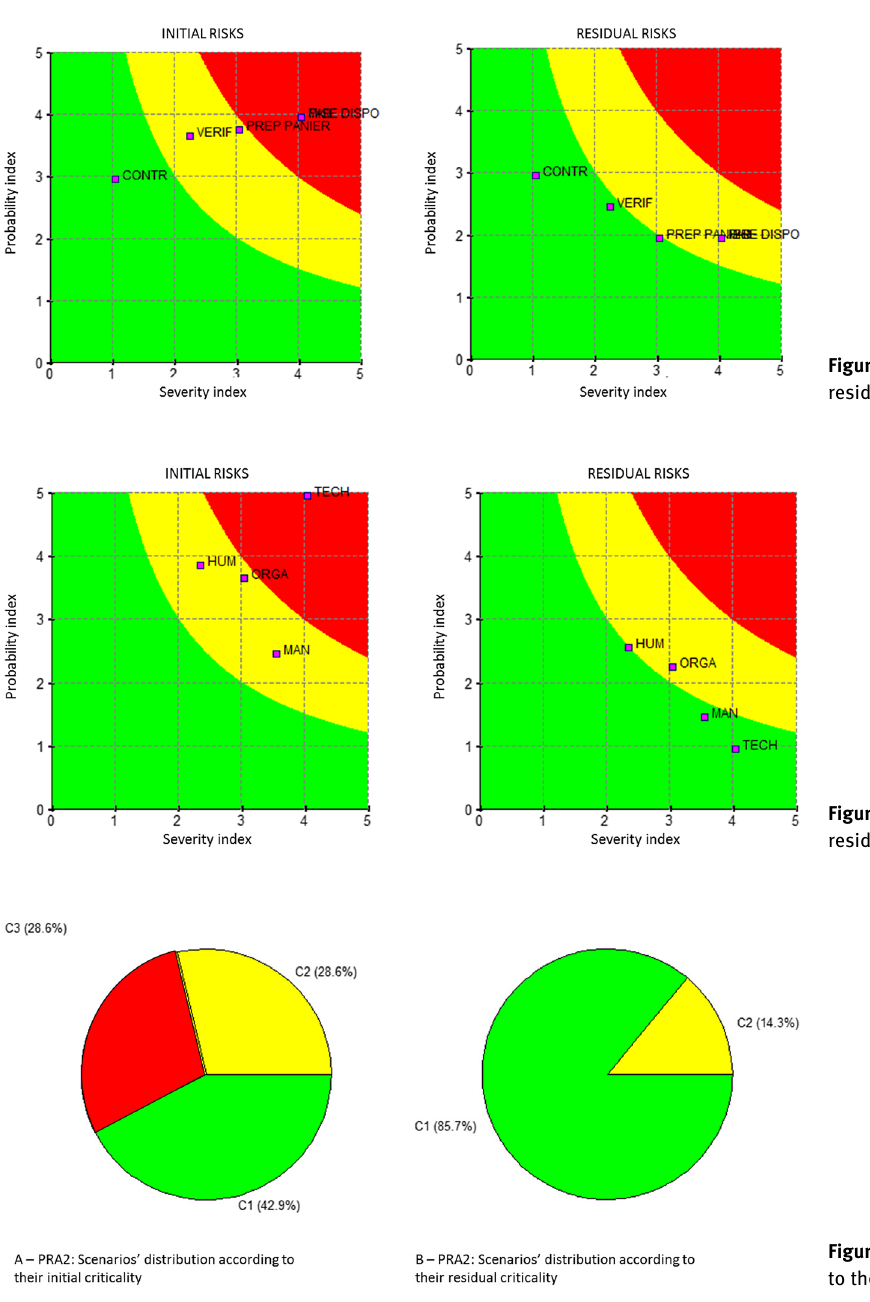
Figure 8: Scenarios ’ distribution according to their criticality for